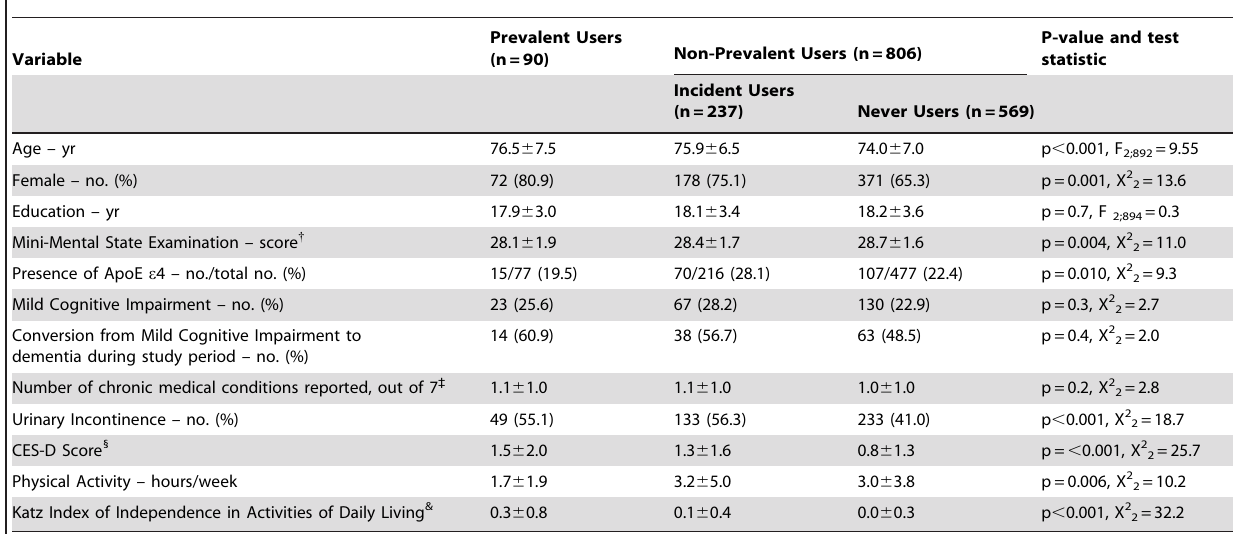
Table 1. Baseline Characteristics of the Participants, According to Study Group.